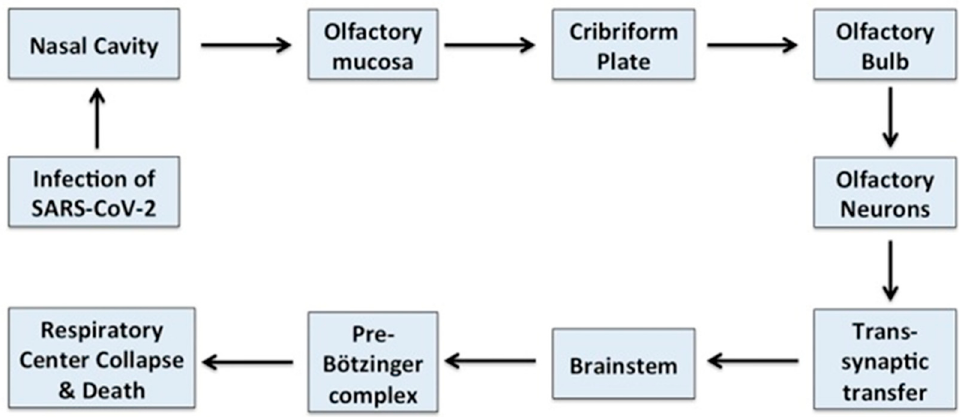
Figure 4. Schematic representation showing how SARSars-CoV-2 may infect the respiratory center of the brain. SARSars-CoV-2 may enter the brain through the olfactory mucosa present in the upper nasal cavity. From there, through olfactory axons, it may access the cribriform plate and project to the olfactory epithelium and olfactory bulb. SARSars-CoV-2 further migrates to deeper parts of the brain such as the thalamus and brainstem by trans-synaptic migration and targets the pre-Bötzinger complex, thus possibly causing the collapse of the respiratory center of the brain [62].